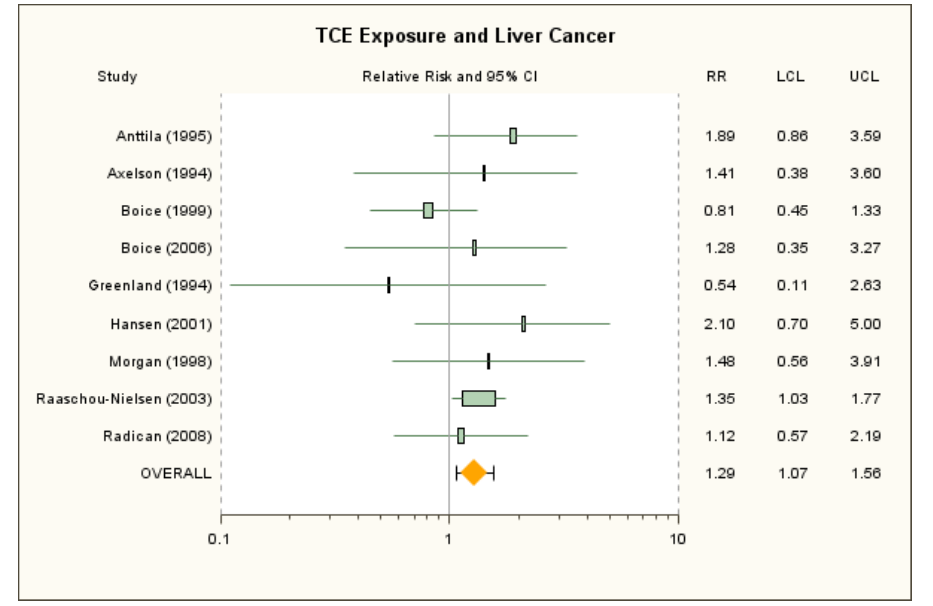
Figure 3. Forest plot of overall TCE exposure and liver cancer from random-effects meta-analysis. Individual study results are plotted with 95% confidence intervals. Symbol sizes reflect relative weights of the 9 cohort studies.